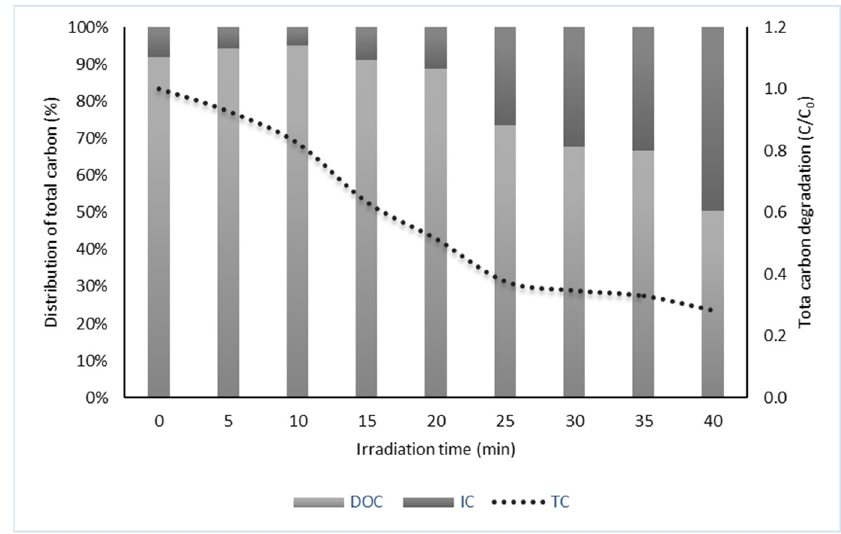
Figure 6. Distribution of inorganic and organic forms of carbon ( left axis ) and evolution of total carbon ( right axis ) during photocatalytic degradation of PNA.